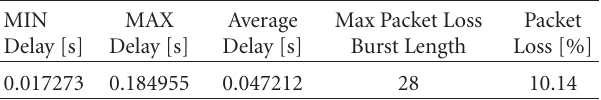
Table 5: WiMAX measurement results considered for